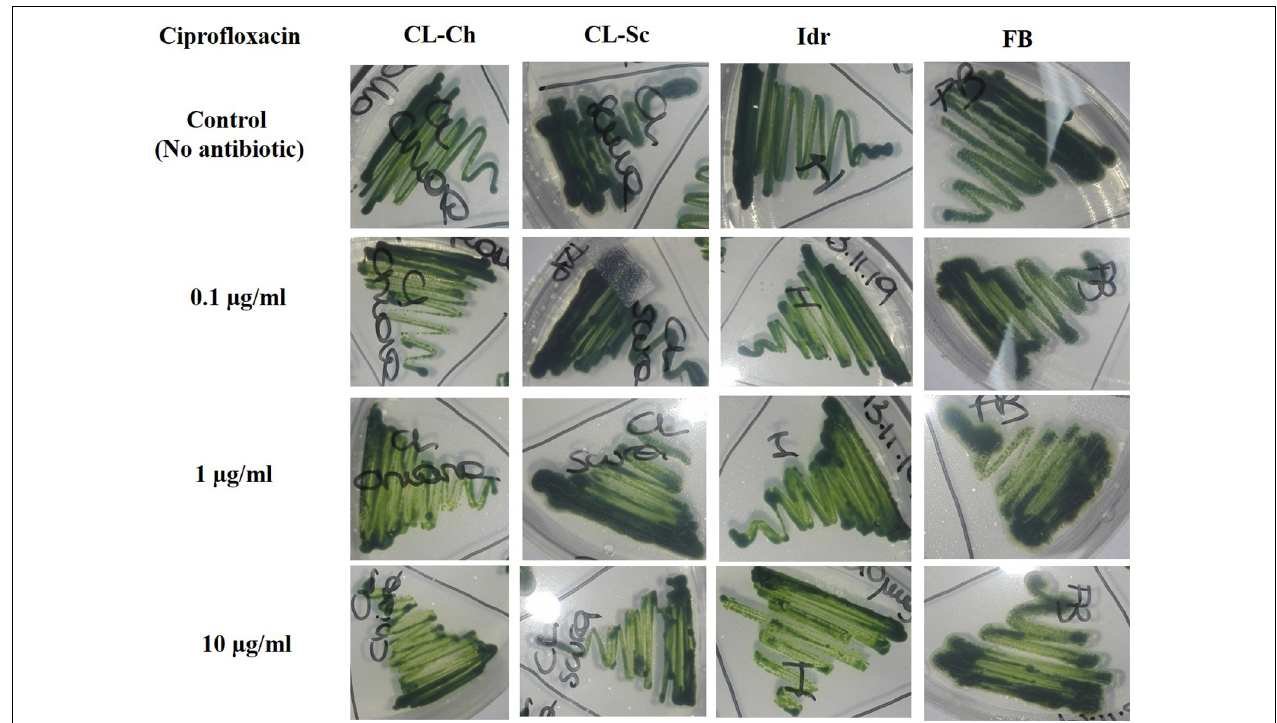
FIGURE 8 | Microalgal growth in presence of different concentrations of Ciprofloxacin (antibiotic substance) in solid agar medium after 7 days